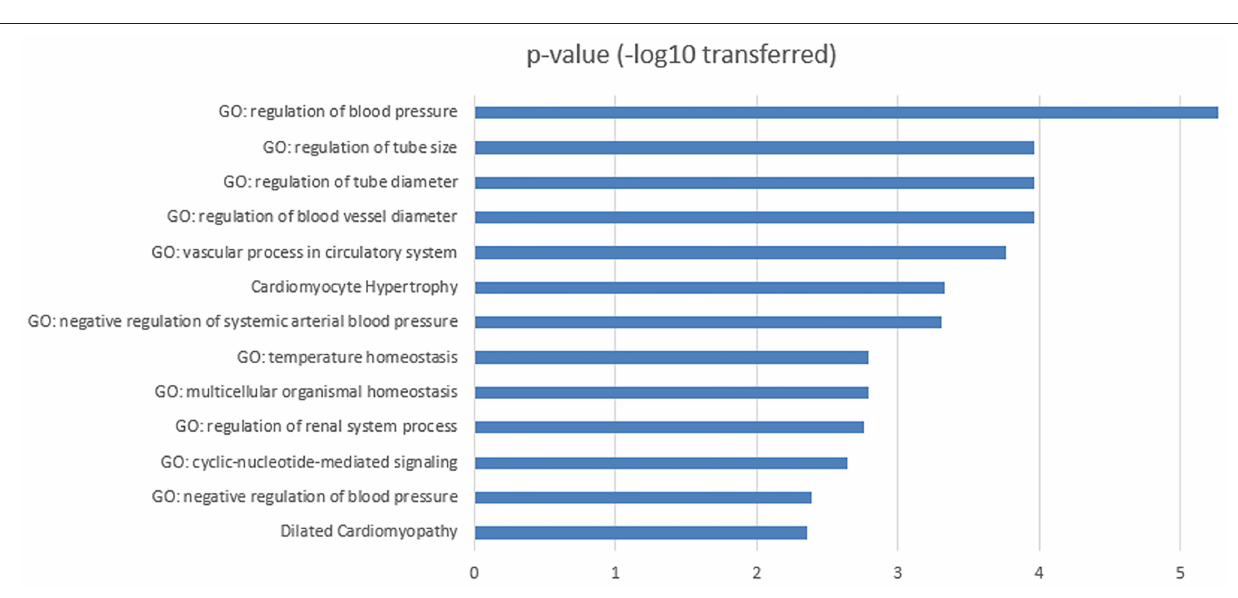
FIGURE 2 | Functional enrichment analysis for the 11 MI-promoters inhibited by obesity within obesity-MI regulatory